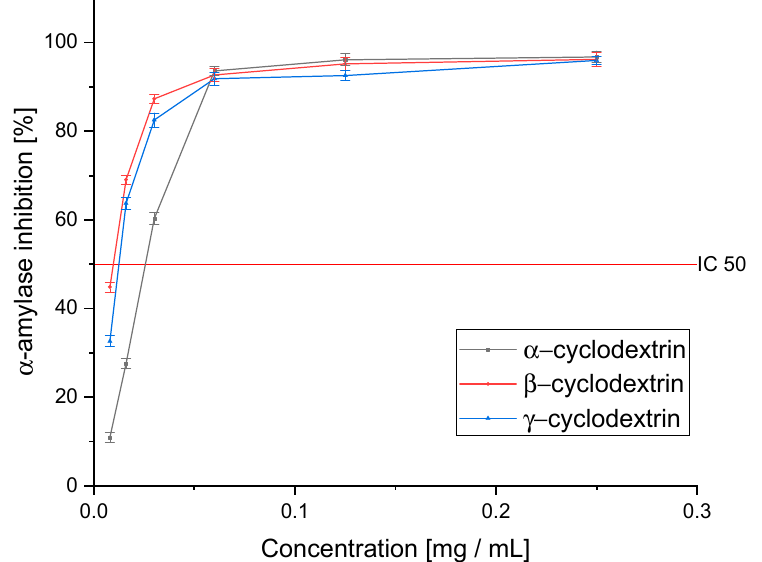
Figure 7. The ability of the extracts obtained using selected cyclodextrins to inhibit α -amylase. Significance at p ≤ 0.05.